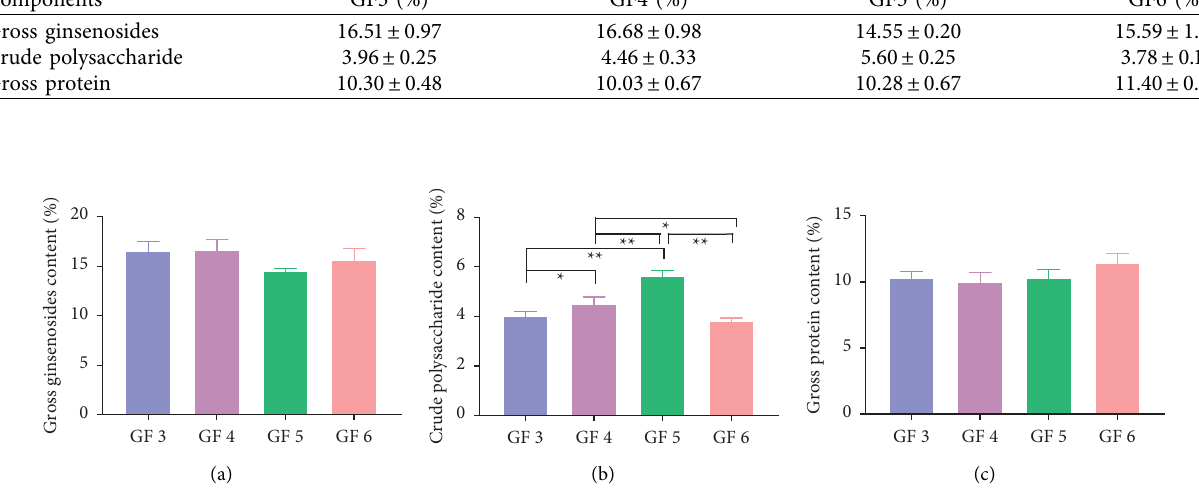
Figure 1: Te content of gross ginsenosides. (a) Crude polysaccharide. (b) Gross protein. (c) In GFs of various ages. GF3, GF4, GF5, and GF6 represent ginseng fowers of 3-, 4-, 5-, and 6-yr-old, respectively, the symbols ∗ and ∗∗ are used to indicate statistical signifcance with p < 0 . 05 and p < 0 . 01,